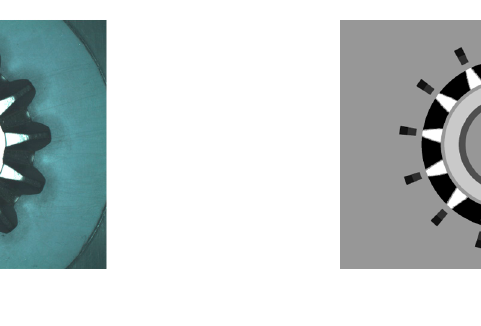
Figure 15. ( a ) Top surface of gear A 4 ; ( b ) The matching template.